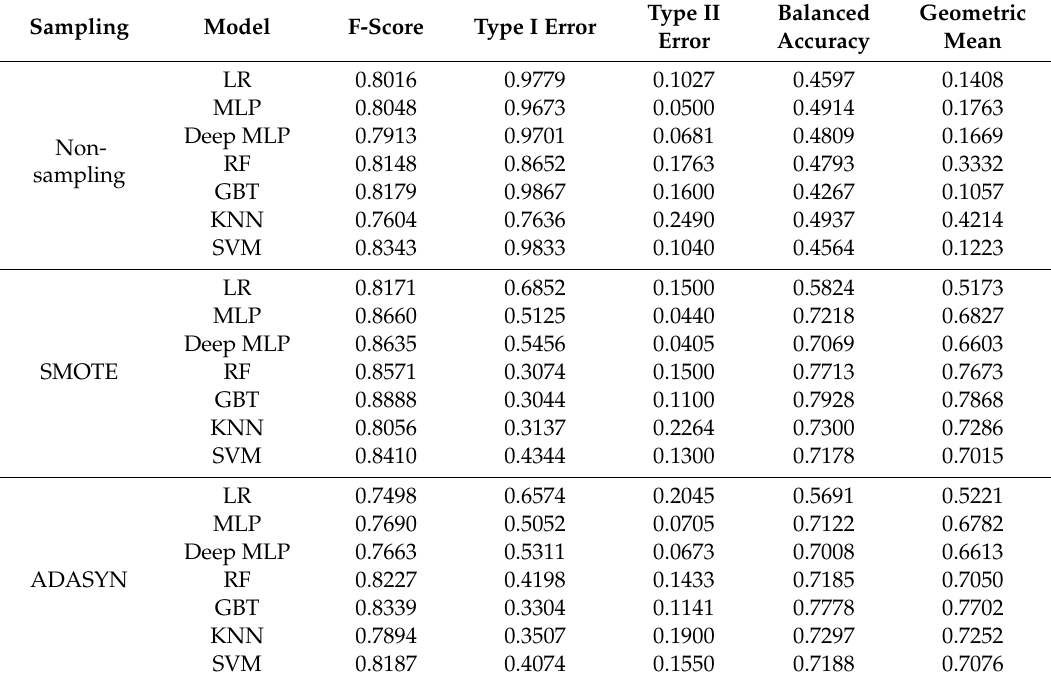
Table 3. Evaluation results of the prediction models among all subjects.